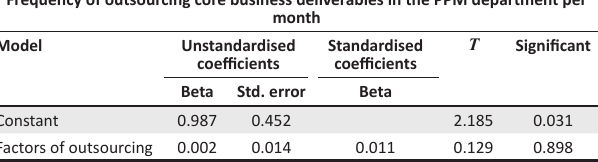
TABLE 5: Effects of outsourcing core business deliverables on business performance. Effects of outsourcing core business deliverables on business performance